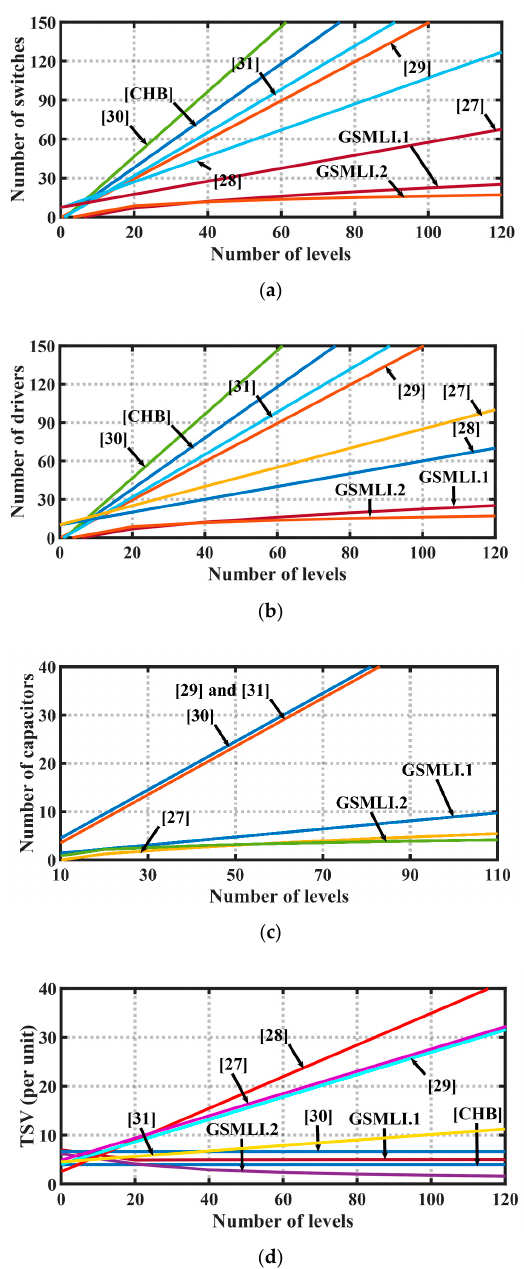
Figure 2. Comparison curves: ( a ) number of switches vs. number of levels, ( b ) number of switches vs. number of levels, ( c ) number of switches vs. number of levels, and ( d ) total standing voltage (TSV) (per unit) vs. the number of levels.